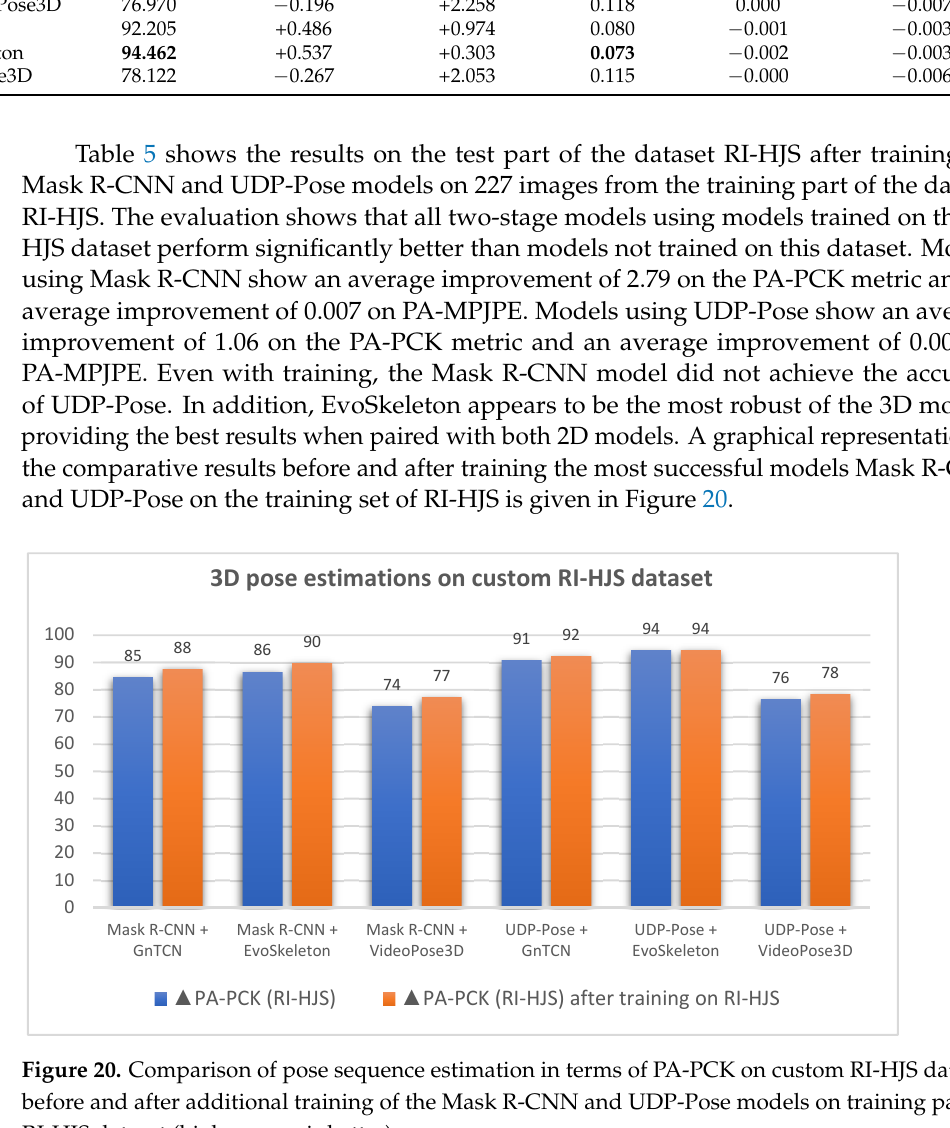
models are shown in Supplementary Figures